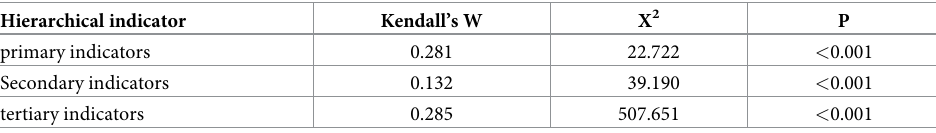
Table 2. The result of expert suggestions’ coordination degree (the first